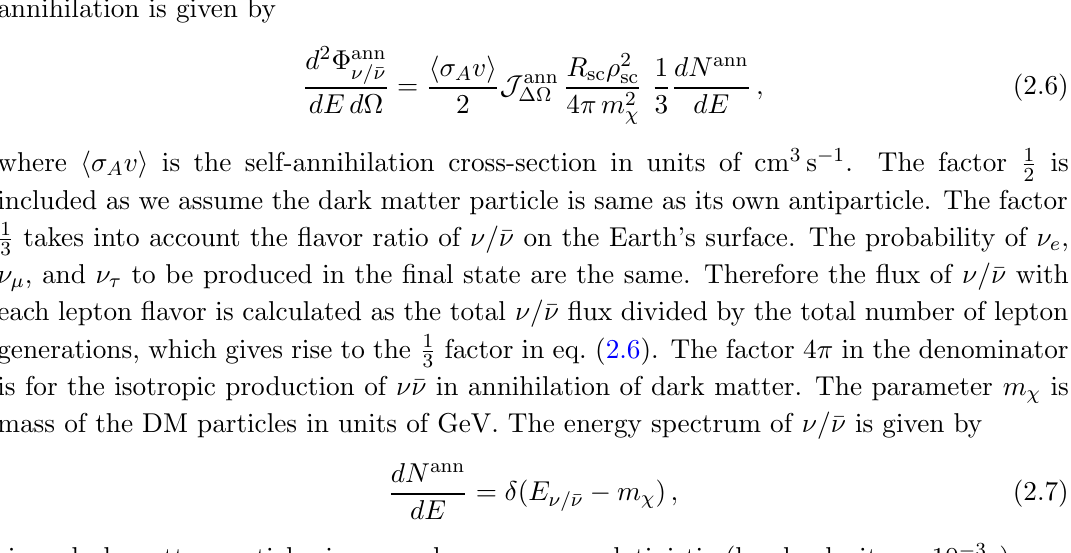
are shown by the black solid